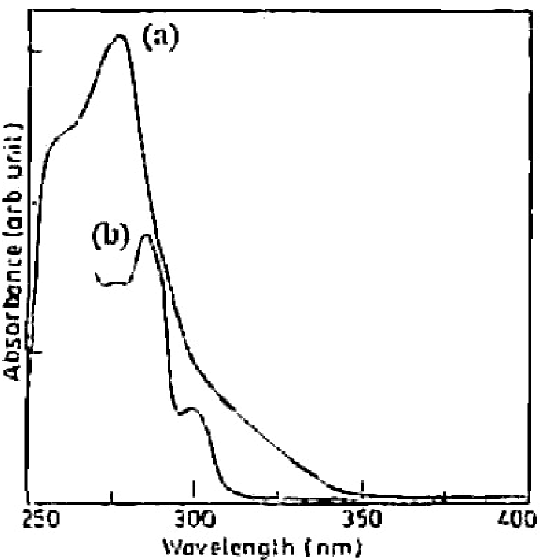
Fig. 2 Absorption spectra of the trimer, T, using ca 10 ¡ 4 M concentrations at 293K in (a) TFA and (b)